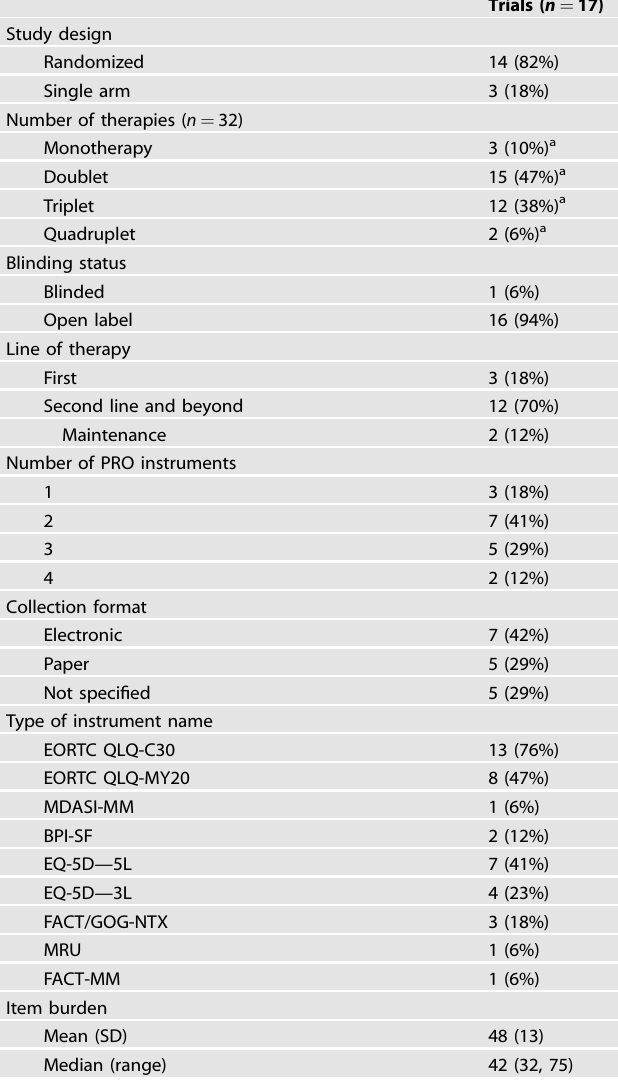
Table 1. Summary characteristics of the pivotal trials used for MM approvals in the